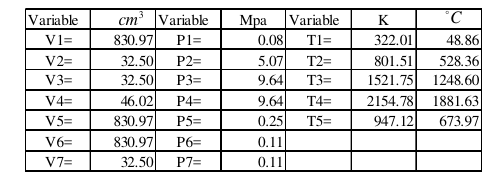
Table 5. Results of the calculation, main points of the indicator